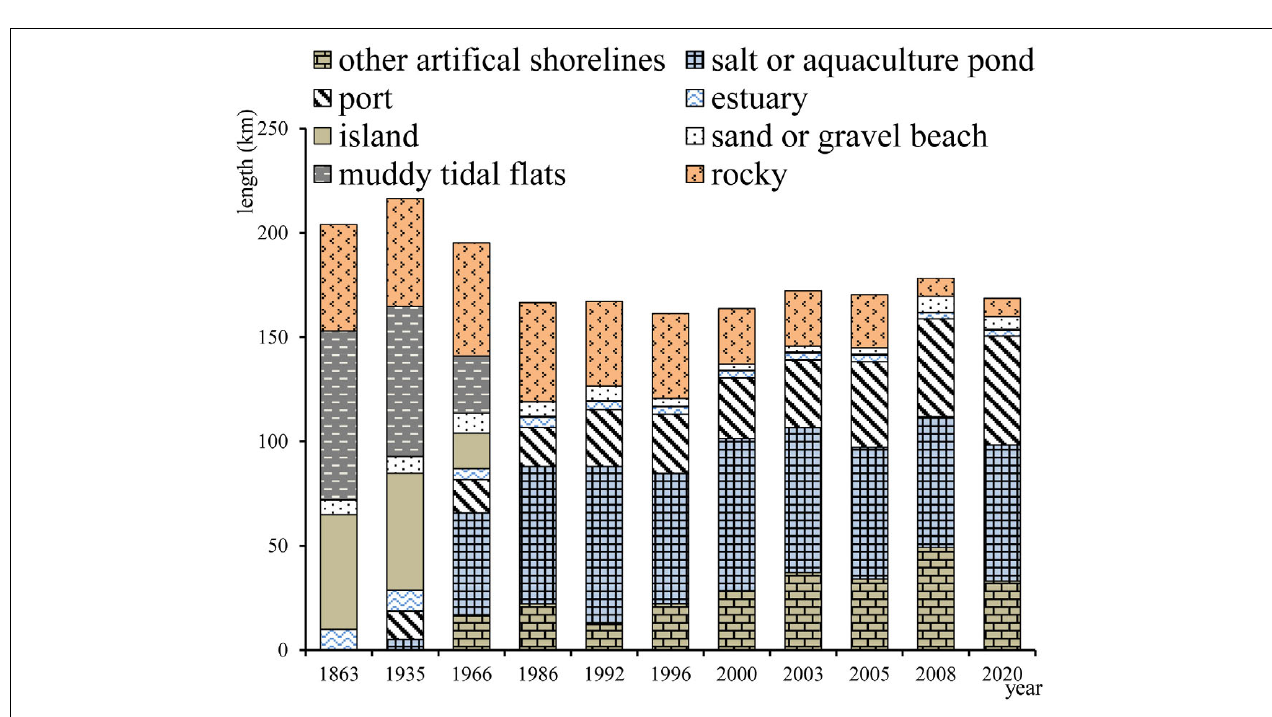
FIGURE 4 | Tidal current speed and direction comparison between model results and measured data at (A) Station C1, (B) Station C2.